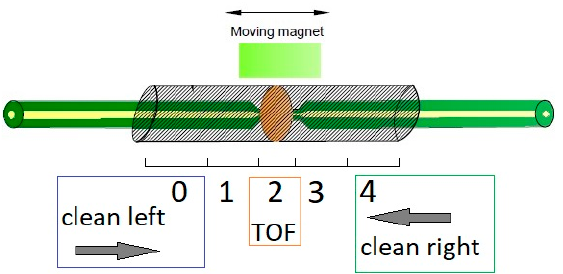
Figure 11. Measurement scheme for determining the effect of the magnetic mixture on the TOF properties. Measurements were started from position “0” and the magnet was moved to position “4” from the left of TOF to the right and backward with the measure in the same position. At each of these points, the Mueller matrix was calculated.